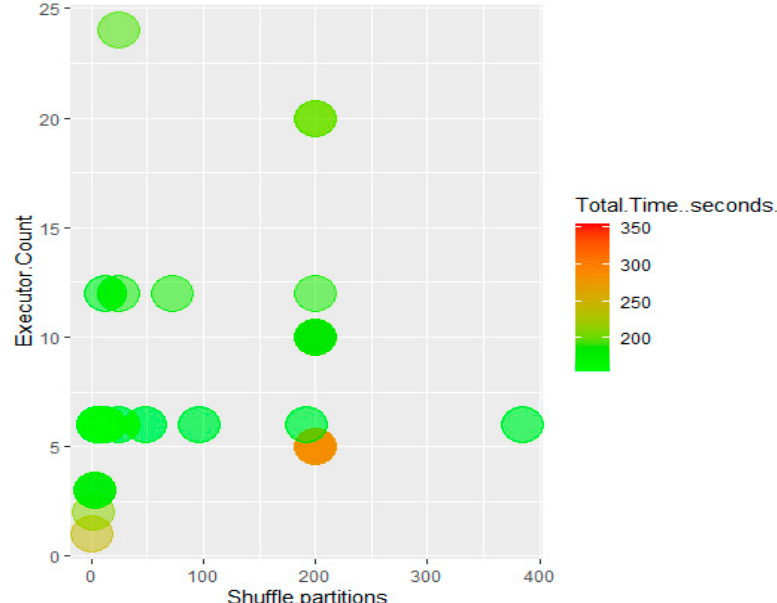
Figure 9. Processing times as a function of executor count and shuffle partitions.